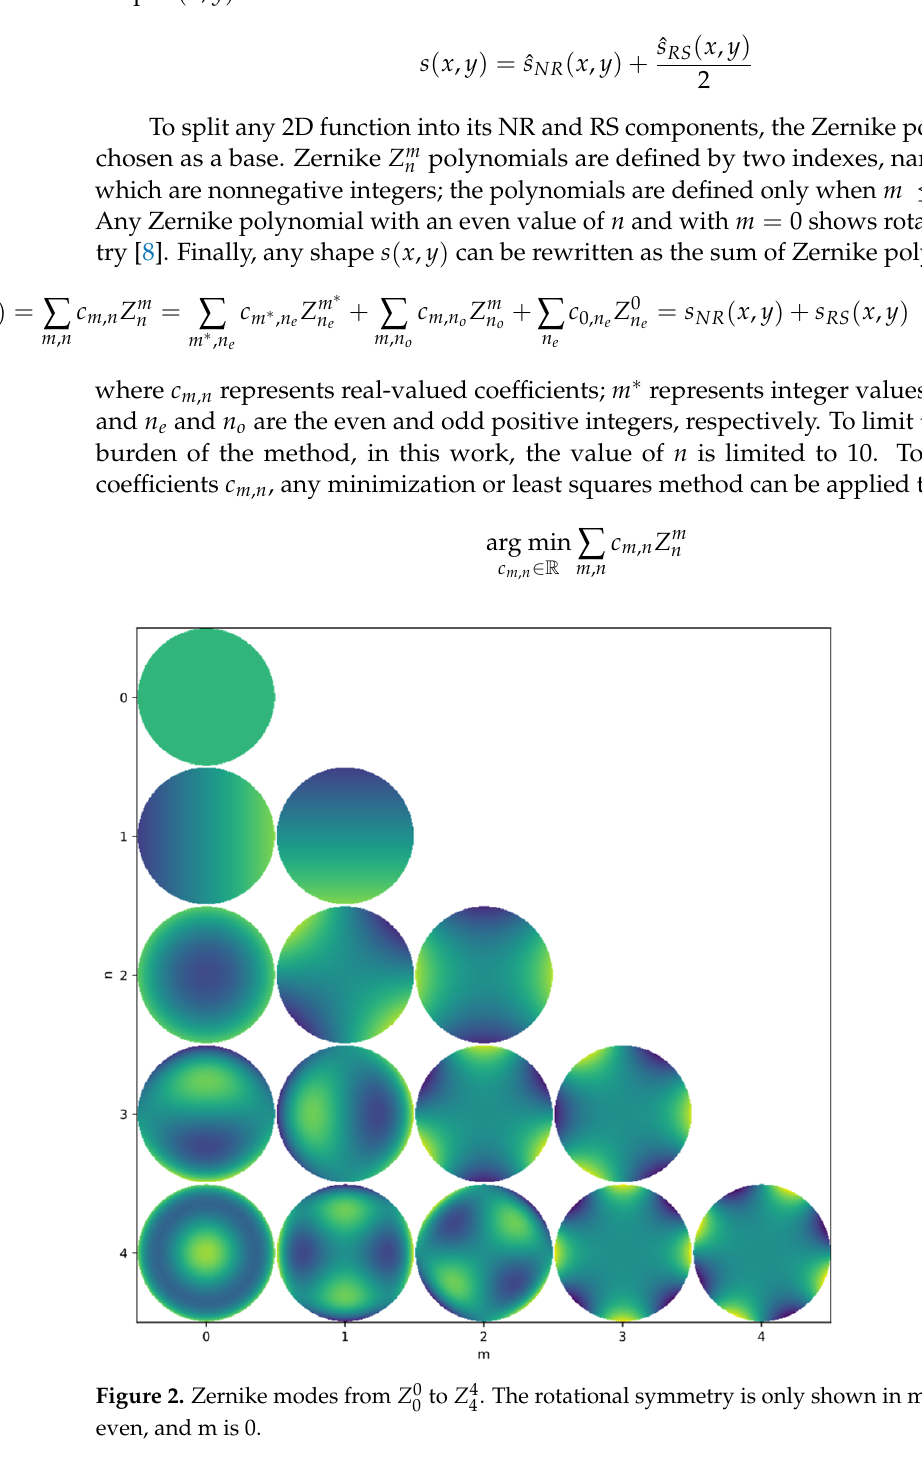
to Z 4 . The rotational symmetry is only shown in modes where n is 0 4